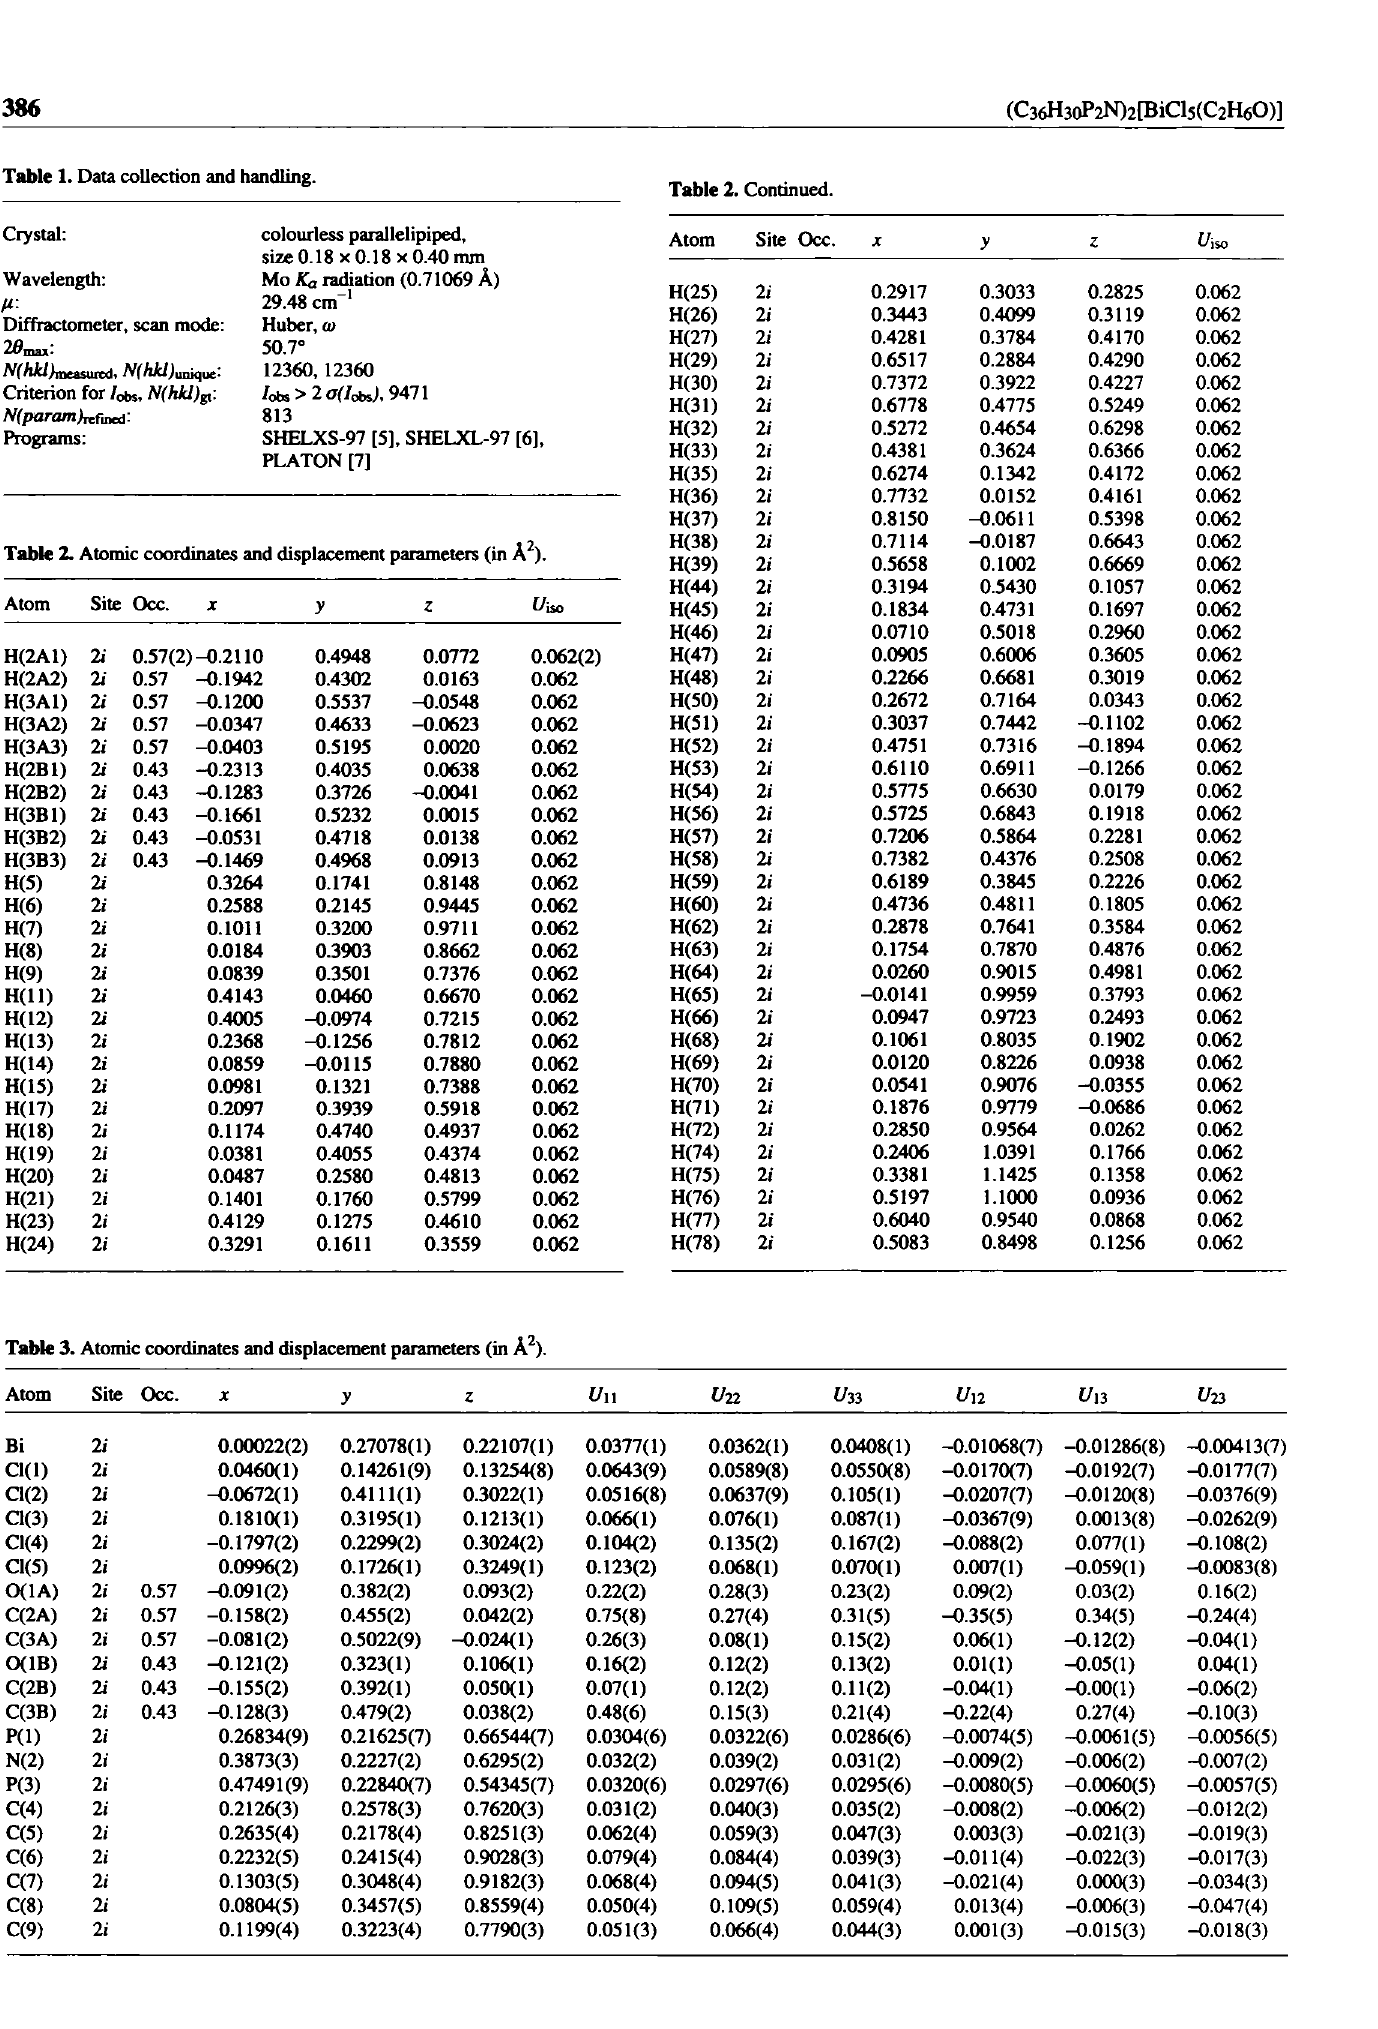
Table 3. Atomic coordinates and displacement parameters (in Â 2 ). Atom Site